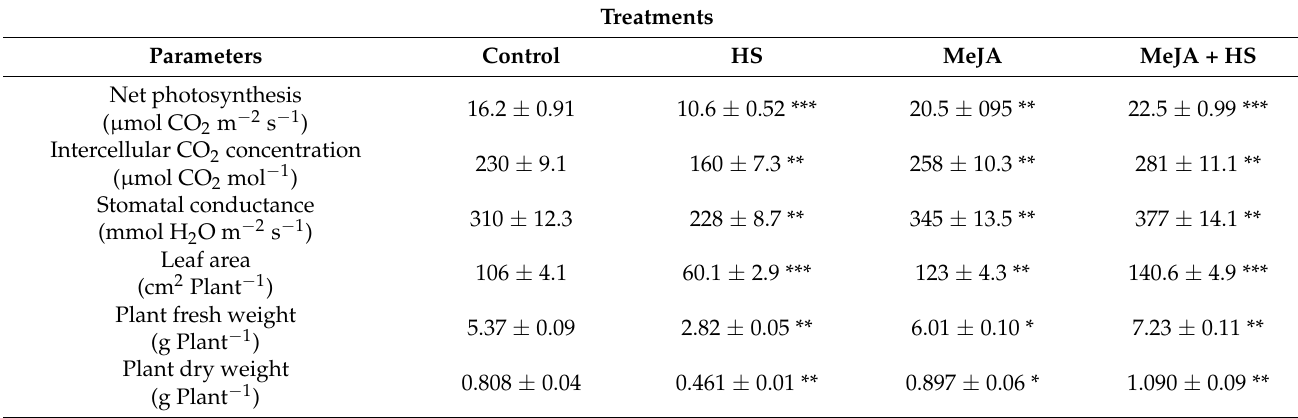
Table 6. Net photosynthesis, intercellular CO 2 concentration, stomatal conductance, leaf area, plant fresh and dry weight of wheat leaves at 30 DAS. Plants were treated with MeJA (10 µ M) at 42 ◦ C (heat stress) or 25 ◦ C (no stress). Data are presented as mean ± SE ( n = 4). Significantly different values between control and treatments are marked with an asterisk (* p < 0.05, ** p < 0.01, *** p < 0.001), determined by Tukey’s test. Chl, chlorophyll; DAS, days after sowing; FW, fresh weight; HS, heat stress; MeJA, methyl